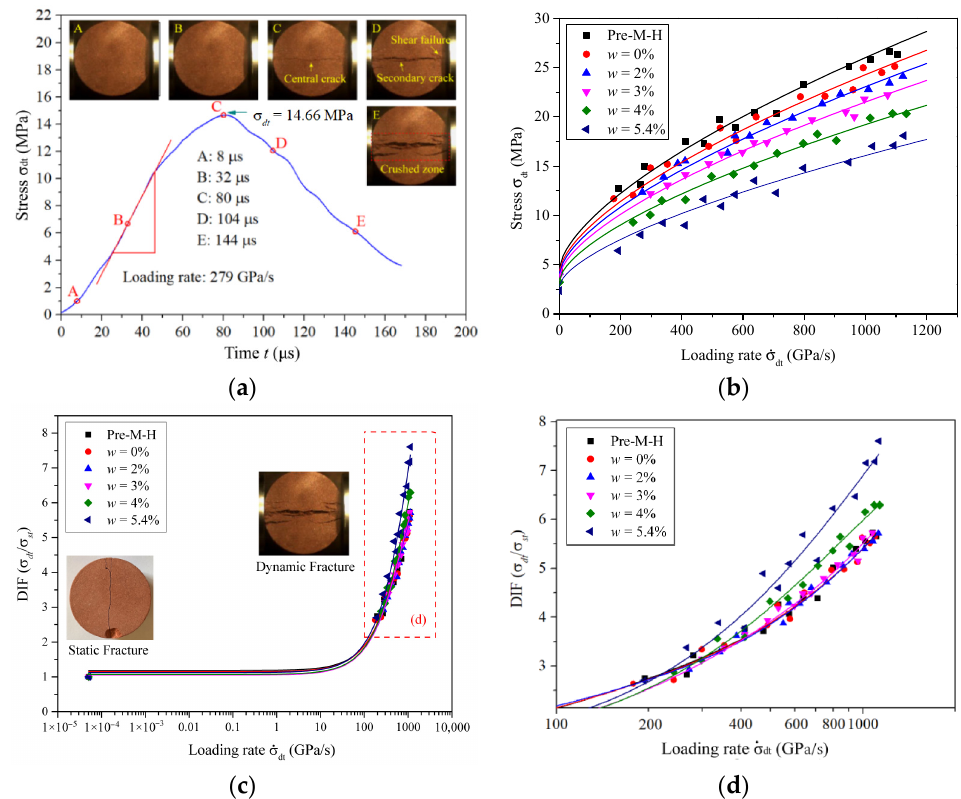
Figure 20. Dynamic Brazilian test results: ( a ) typical stress-time curve of sandstone sample under impact loading; ( b ) dynamic tensile strength of the samples under different loading rates; ( c ) relation between dynamic increase factor and loading rate; ( d ) magnification of view ( c ).